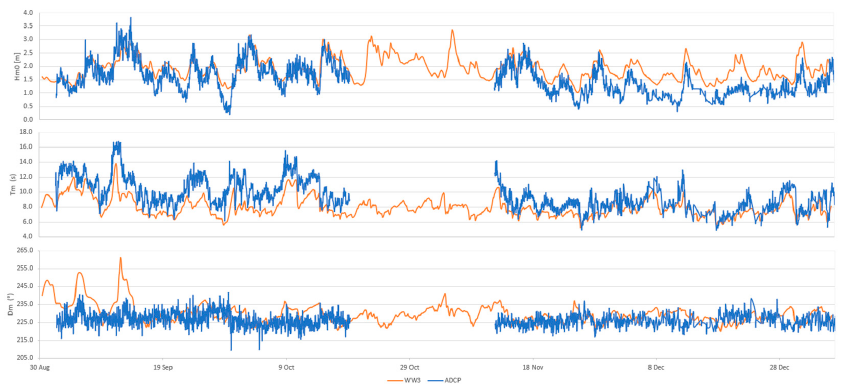
Figure 8. Time series of the significant spectra for wave height (Hm0 (m)), mean period (Tm (s)), and mean direction (Dm (°)) between 31 August 2021 and 29 December 2021. The orange line corresponds to the hindcast of the WW3 numerical modeling in the vicinity of the OPT buoy. The blue line corresponds to the processed results of the ADCP during the same period.